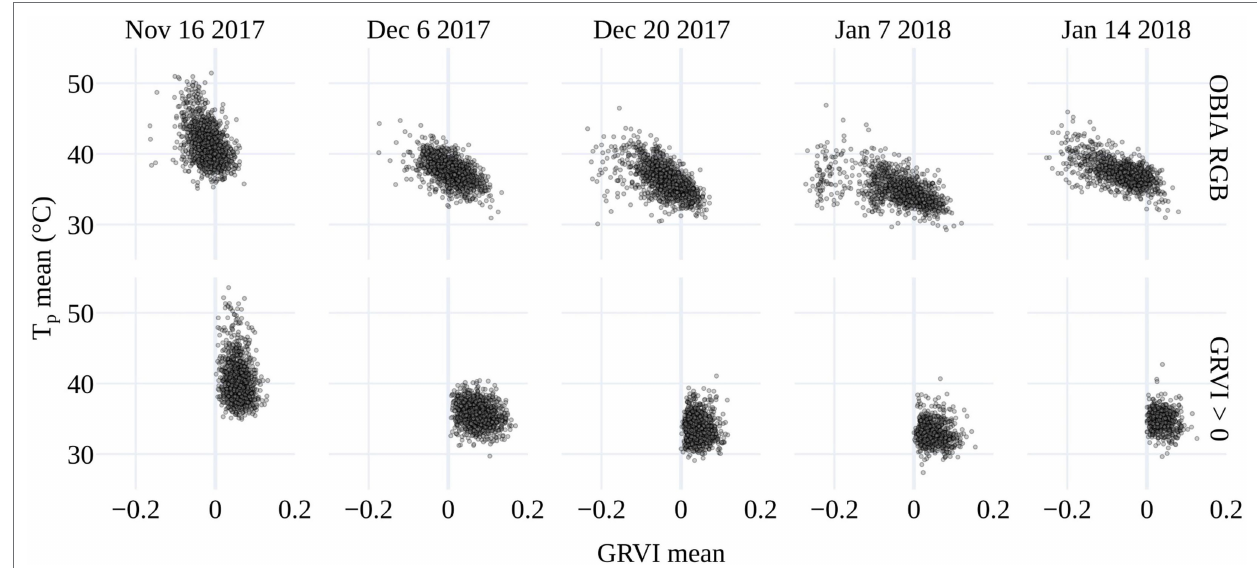
FIGURE 5 | The relationship between mean plant temperature (T p ) and the mean GRVI for the OBIA delineations (top) and GRVI > 0